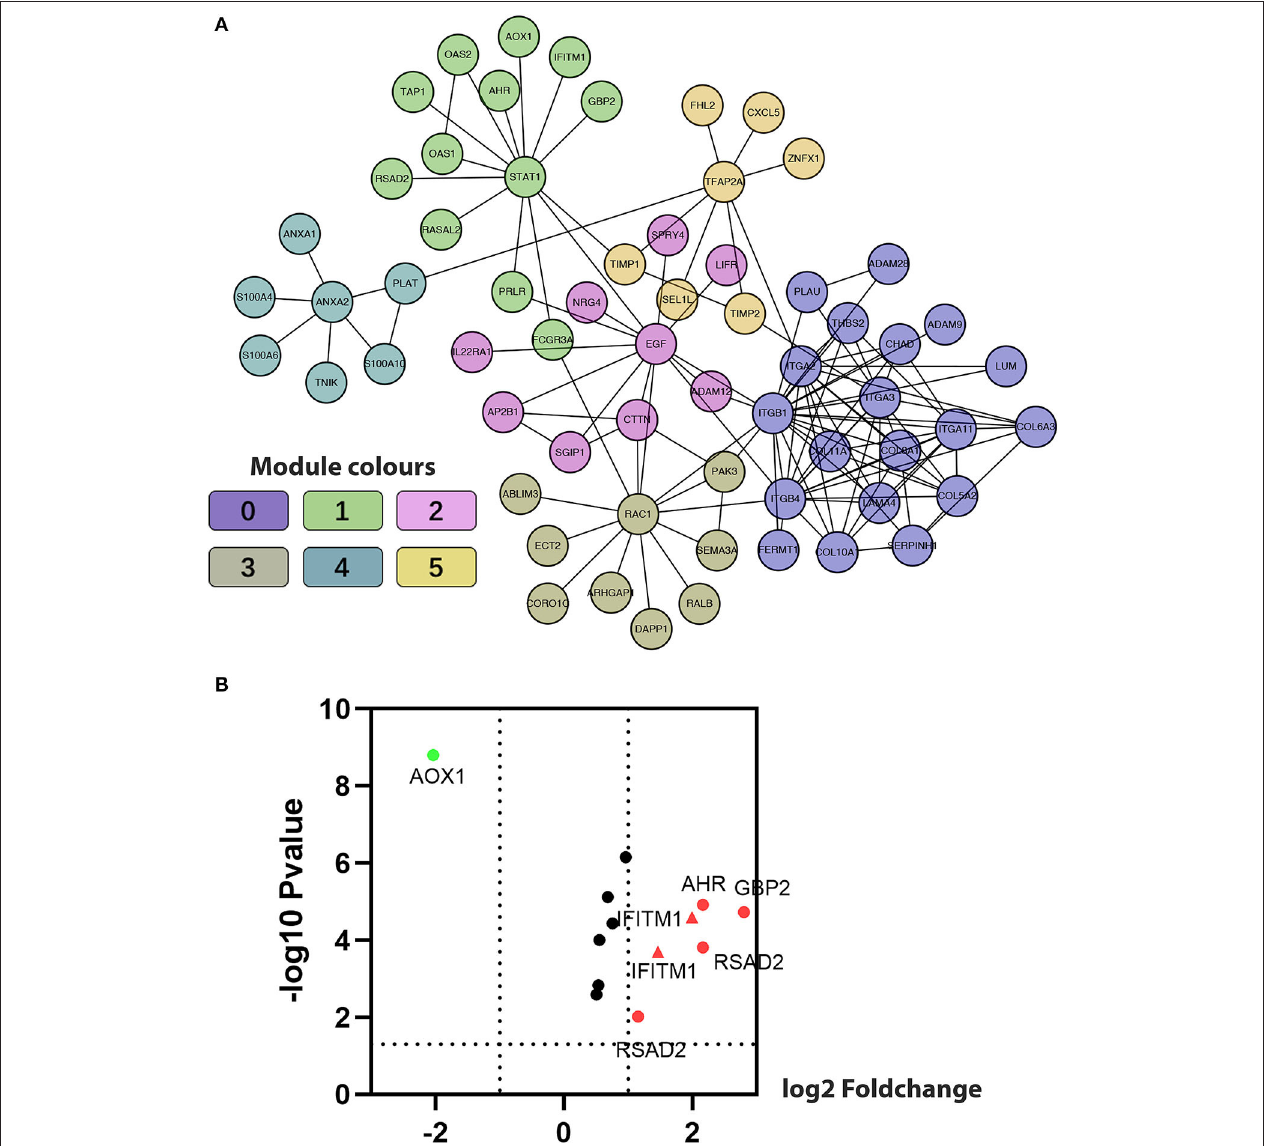
FIGURE 3 | Construction of functional interaction (FI) network-based module genes. (A) A functional network constructed by six FI-based modules comprises 23 genes in different colors. (B) A volcano map shows differentiating pancreatic cancer samples from normal samples, with red representing significantly upregulated genes, green representing significantly downregulated genes, and the red triangle representing IFITM1.